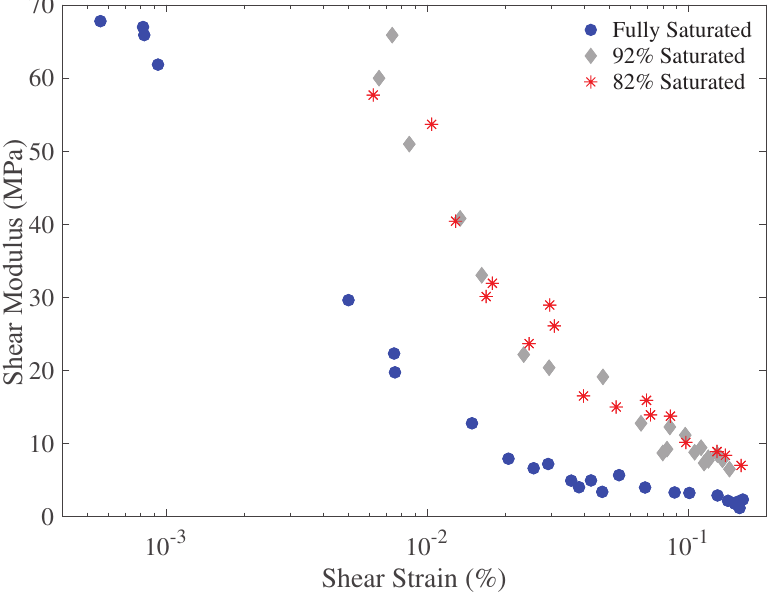
Figure 11. Shear modulus reduction curve for soil deposits with different degrees of saturation at D = 2.7 m.